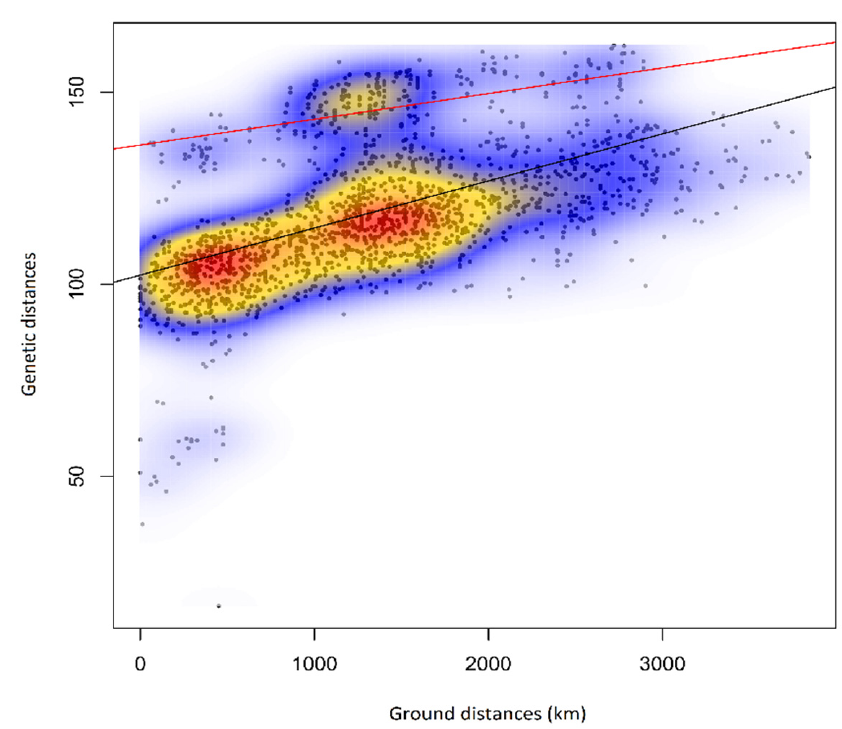
Figure 5. Isolation by distance plot illustrating the pattern of genetic differentiation in the M. athalia – M. celadussa species group (r 2 = 0.536, p = 0.001) in relation to pairwise geographic distances. The black line represents the overall trend, while the red line represents the relationship between the Balkan clade and the group composed by main M. athalia + M. celadussa